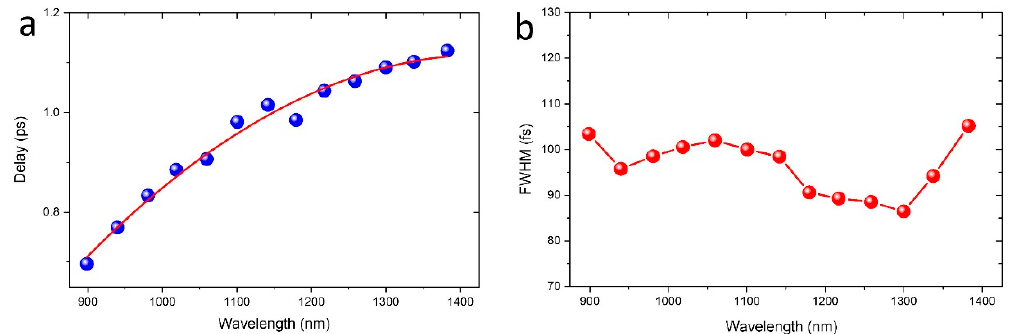
Figure 3. ( a ) Relative delay of the overlap pump-probe: the blue points are the results of the fitting procedure for the kinetic traces extracted from the 2D data set in Figure 2a. The solid red curve represent a polynomial (of order 2) fit of the data. ( b ) Time resolution as a function of the probe wavelength. The red circles represent the Full Width at Half Maximum ( FWHM ) extrapolated by the gaussian fit of the kinetic traces. The red solid line is a guide for eye.